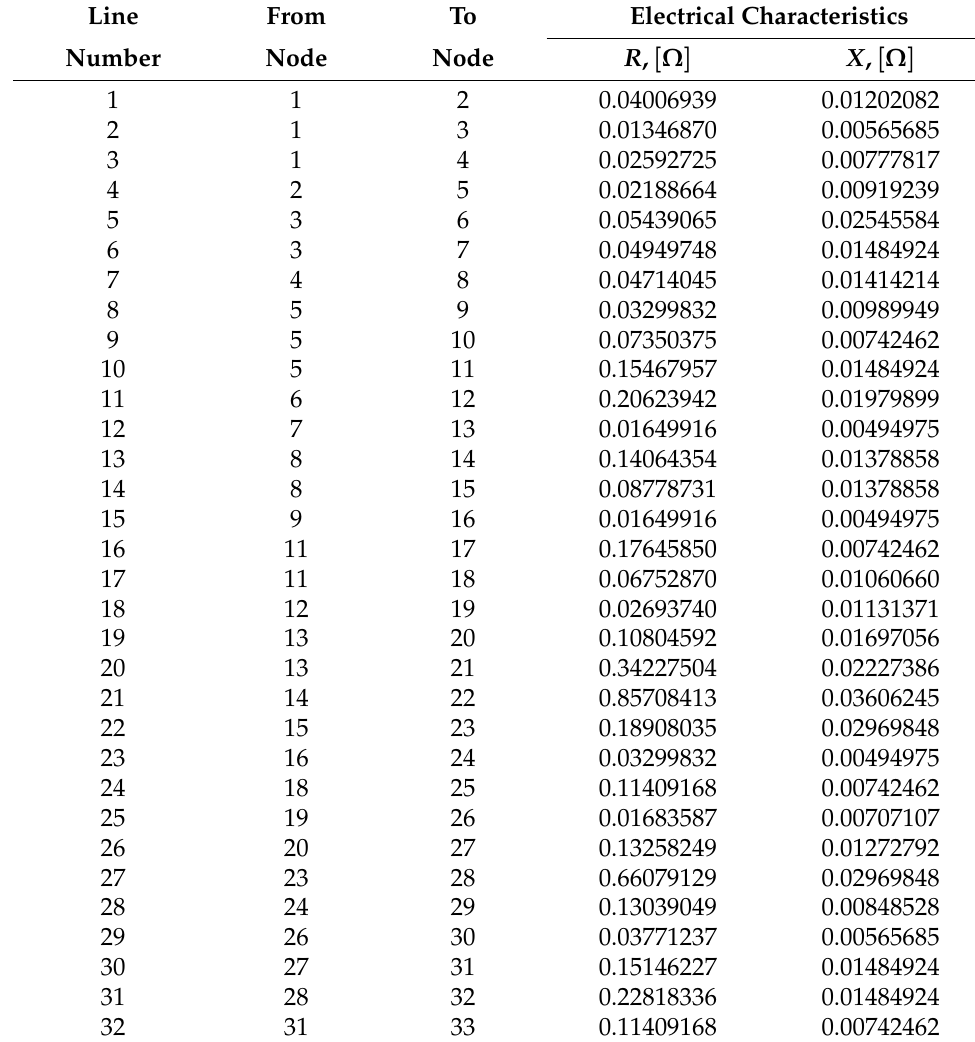
Table A5. Network characterization and electrical characteristics of the inductive network scenario Line From To Electrical